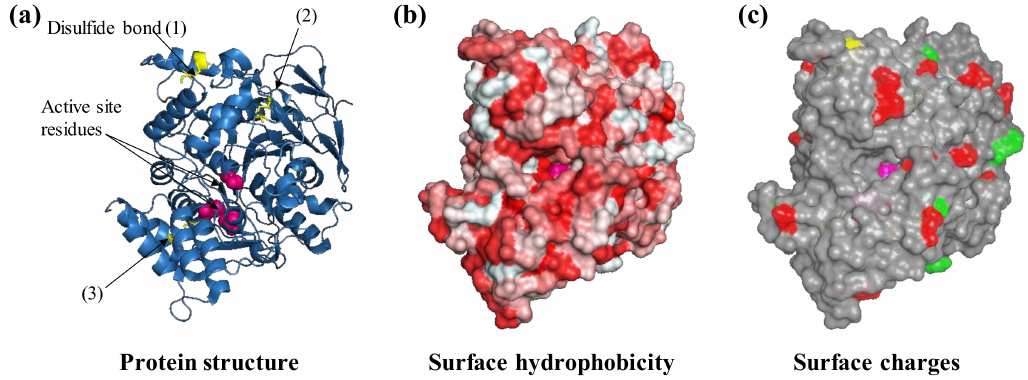
Figure 2. Protein features to consider before selecting an immobilization strategy. For example, the protein acetylcholinesterase from the electric eel Electrophorus electricus (PDB ID: 1c2b) is shown. The three-dimensional structure of acetylcholinesterase is shown as ribbons ( a ) with three visible disulfide bonds (yellow sticks) and active site residues highlighted (pink spheres, b ), negatively (green) and positively charged Lys residues (red) that are exposed on the surface ( c ). Protein structures are visualized with Pymol (The PyMOL Molecular Graphics System, Version 1.2r3pre, Schrödinger,